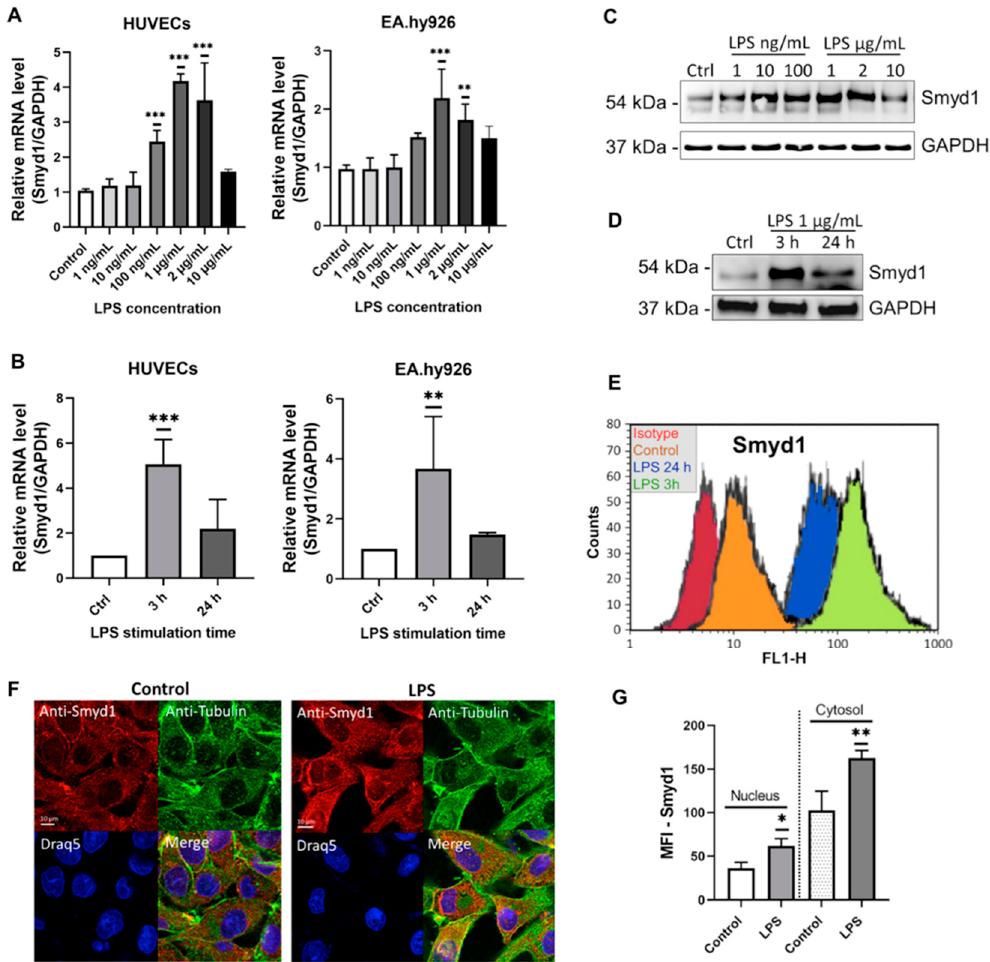
Figure 1. LPS stimulation increases Smyd1 expression in endothelial cells. ( A ) RT-qPCR for the quantification of Smyd1 mRNA levels in HUVECs and EA.hy926 cells that were stimulated with different concentrations of LPS ranging from 1 ng/mL to 10 µ g/mL for 3 h. Expression values relative to control (no LPS supplement). n = 3, ** p < 0.01, *** p < 0.001 using one-way ANOVA. ( B ) RT-qPCR for the quantification of Smyd1 mRNA levels in HUVECs and EA.hy926 cells that were stimulated with 1 µ g/mL LPS for 3 h or 24 h. Expression values relative to control (Ctrl, no LPS supplement). n = 3, ** p < 0.01, *** p < 0.001 using one-way ANOVA. ( C ) Immunoblotting for the determination of Smyd1 protein levels in total lysates of EA.hy926 cells incubated with different concentrations of LPS ranging from 1 ng/mL to 10 µ g/mL for 3 h in comparison to no LPS supplement (Ctrl). Representative immunoblot of n = 3. ( D ) Immunoblotting for the determination of Smyd1 protein levels in total lysates of EA.hy926 cells after incubation with 1 µ g/mL LPS for 3 h or 24 h in comparison to no LPS supplement (Ctrl). Representative immunoblot of n = 3. ( E ) Representative flow cytometry histograms of EA.hy926 cells stimulated without LPS or with 1 µ g/mL LPS for 3 h or 24 h and incubated with a monoclonal antibody recognizing Smyd1 and, subsequently, fluorescence-labeled secondary antibodies. An isotype-matched monoclonal IgG was used as control. n = 3. ( F ) Immunocytochemistry with anti-Smyd1 (red) and anti-Tubulin (green) antibodies on EA.hy926 cells incubated for 3 h with vehicle only (Control) or LPS (1 µ g/mL). Draq5 staining for labeling of cell nuclei (blue). Representative images of n = 3 experiments. ( G ), Mean fluorescence intensity (MFI) of Smyd1 immunoreactivity, as shown in F, was densitometrically determined in the nucleus (left two columns) and the cytosol (right two columns). n = 3 independent experiments each with 20 cells evaluated. * p < 0.05, ** p < 0.01 using Student t -test. All graphs reported as mean ±